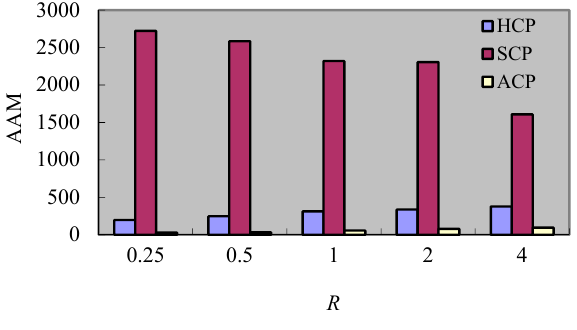
Figure 15. Impact of R on AAM.